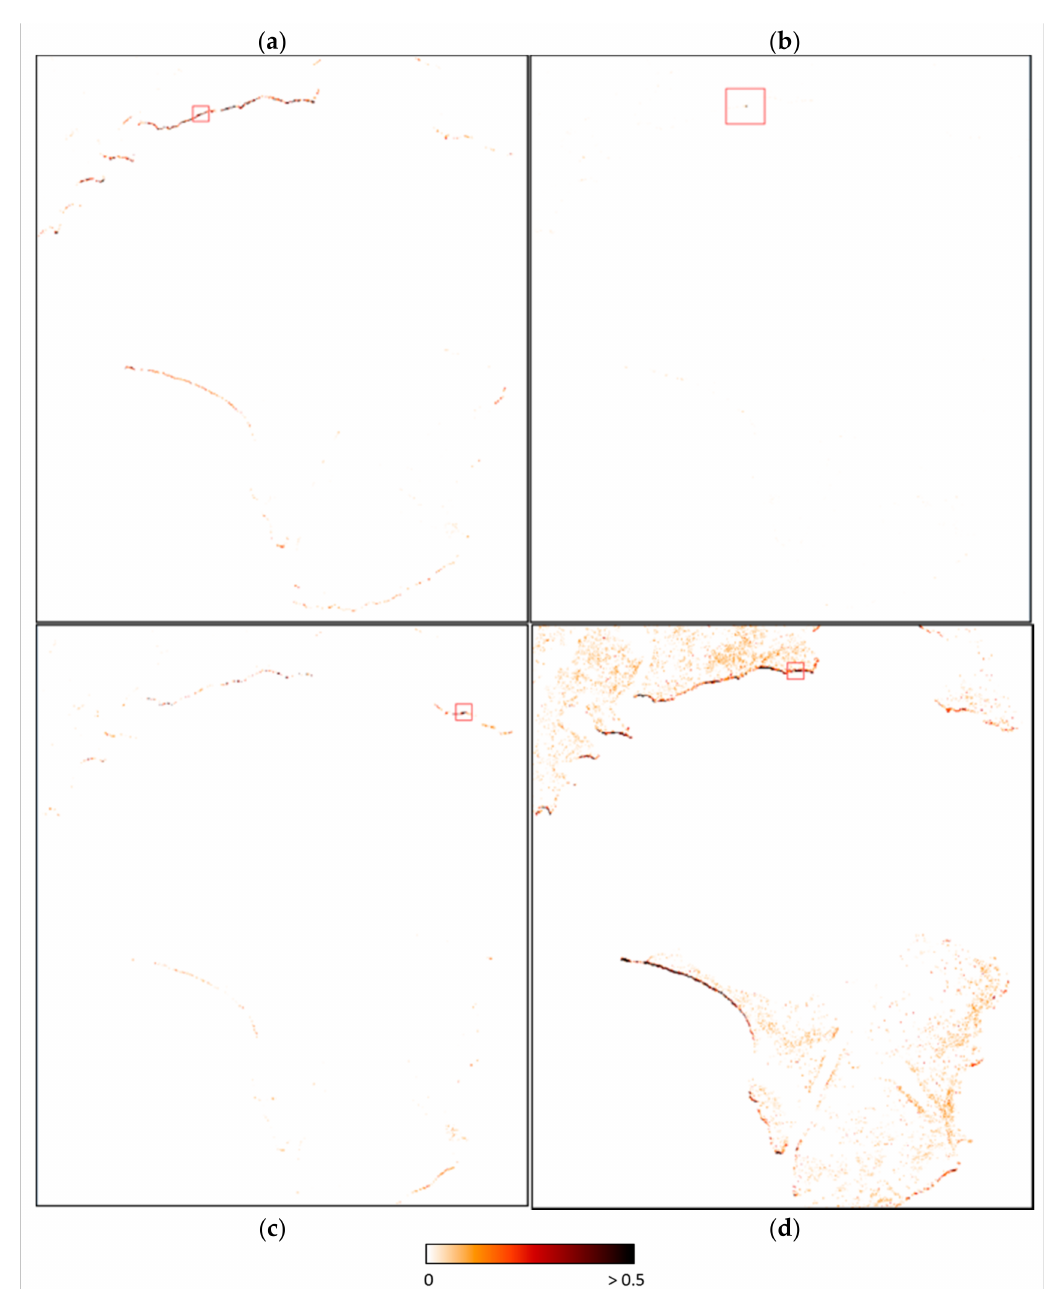
Figure 15. Abundance maps of the 3rd ( a ), 5th ( b ), 14th ( c ) and 17th ( d ) endmembers. Histograms are adjusted on the entire images (linear stretch [0, 0.5]). Pixels with the maximum abundance values (equal to 1) are at the centers of the red